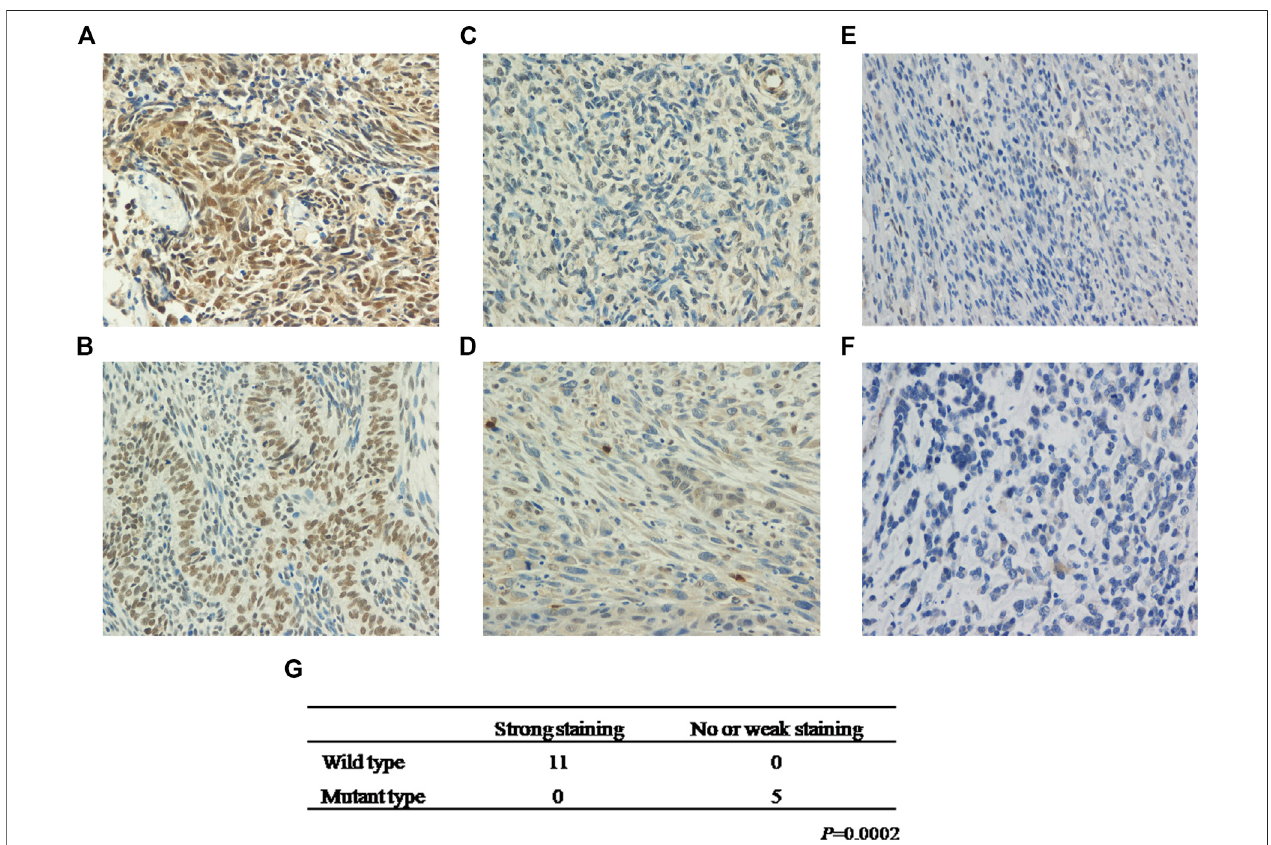
FIGURE3| KMT2DmutationsarenegativelyassociatedwithKMT2Dexpression.StrongstainingofKMT2DinMSCswithnoKMT2Dmutationoriginatingfromthe breast ( A , Patient ID 2) and esophagus ( B , Patient ID 11). Week staining of MSCs with a single mutation in KMT2D originating from the lung ( C , Patient ID 14) and esophagus( D , Patient ID 13). Loss ofKMT2D expression in MSCs with double mutations in KMT2D originatingfrom the breast ( E , Patient ID 8) and kidney ( F , Patient ID 16). (G) The relationship between KMT2D mutation status and protein